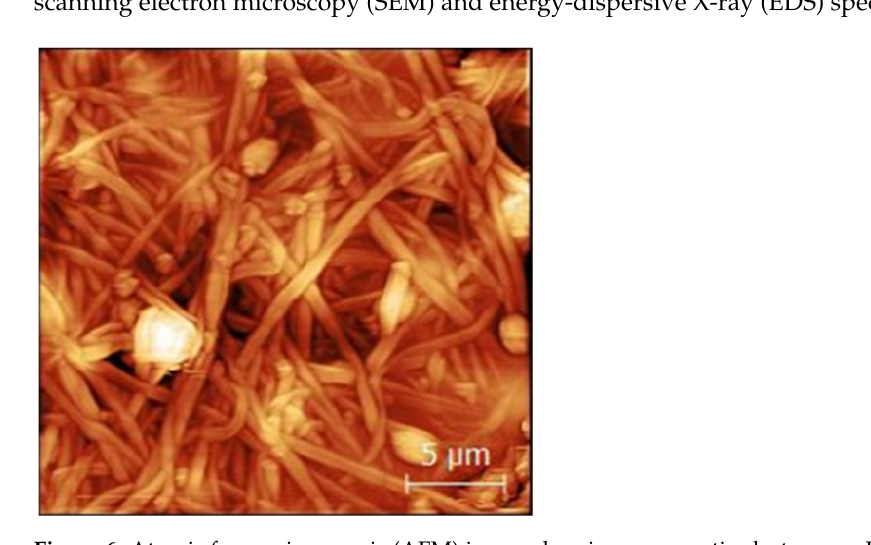
Figure 6. Atomic force microscopic (AFM) image showing a magnetic electrospun PAN nanofiber mat with 20 wt% Fe 3 O 4 . The scale bar indicates 5 µm. Adapted from [208], originally published under a CC-BY license.